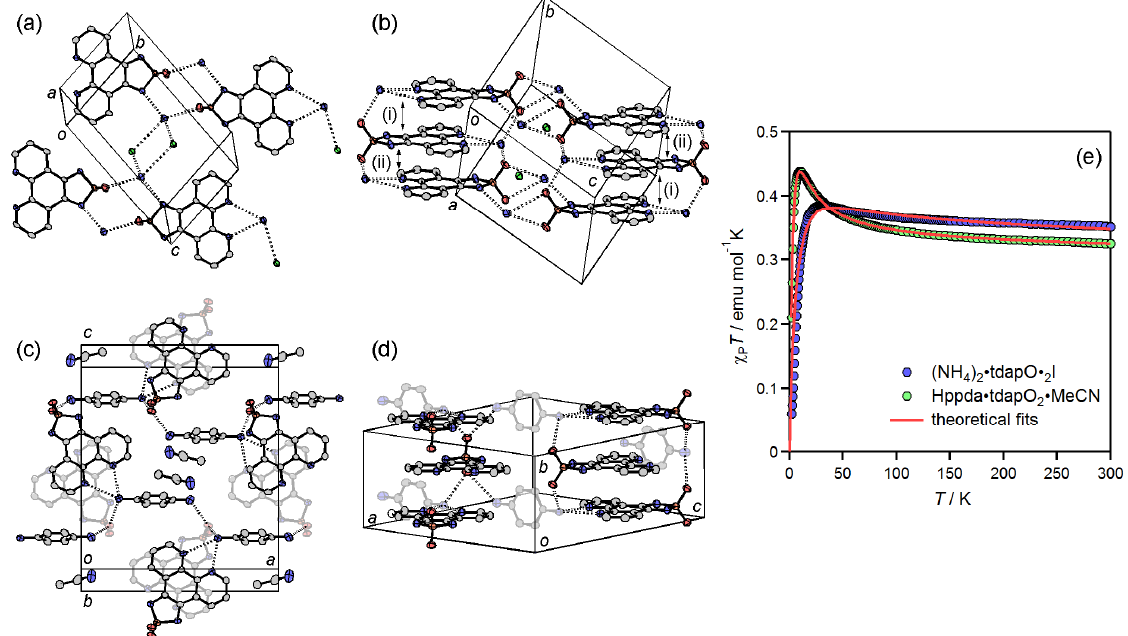
) •tdapO •I ( a , b ) and Hppda•tdapO 4 2 2 T for (NH ) •tdapO •I and Hppda•tdapO p 4 2 2